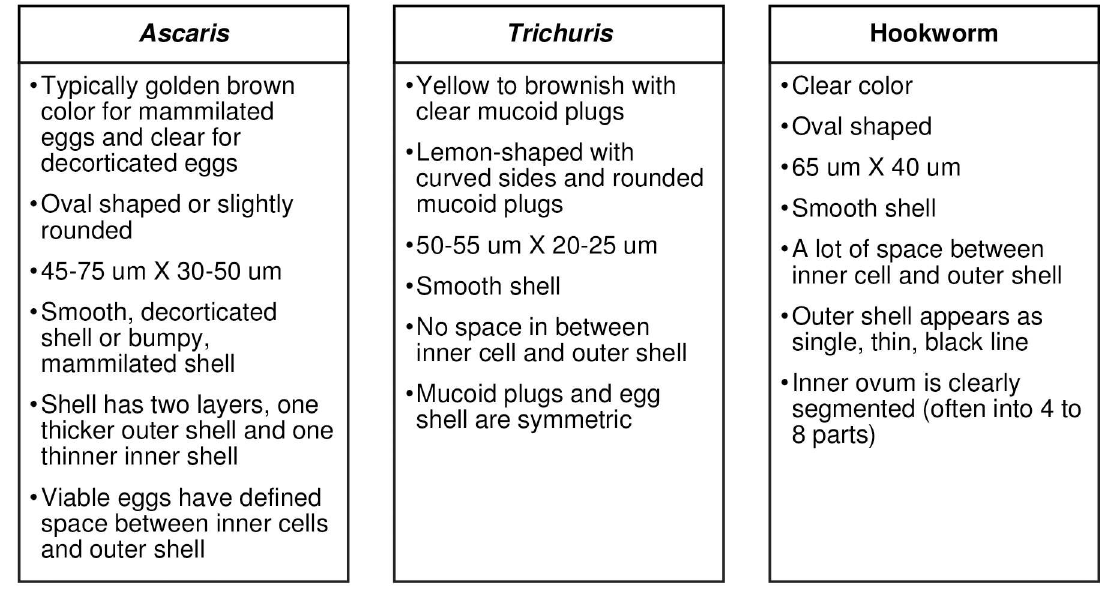
Fig 2. Characteristics of STH